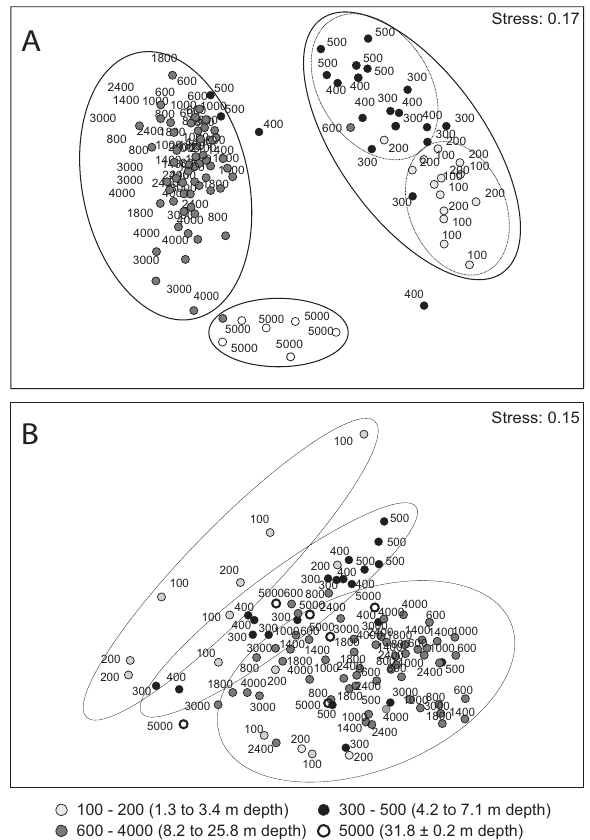
Fig. 5 . – MDs ordination plot of the macrobenthic community for the a) species densities and the b) feeding guild densities.